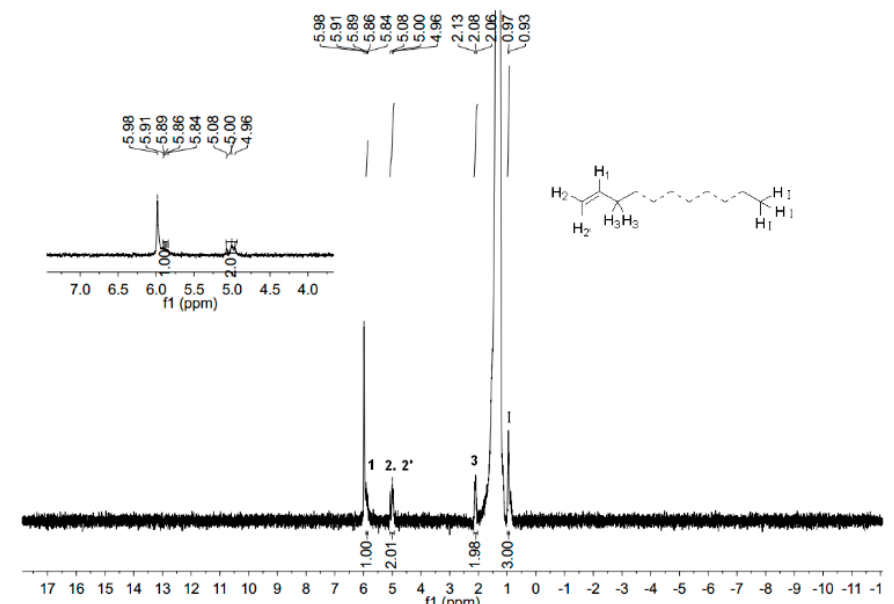
Figure 5. 1 H ‐ NMR spectrum of the polyethylene obtained using Co2 /MAO at 50 °C (run 9, Table 2); recorded in 1,1,2,2 ‐ tetrachloroethane ‐ d 2 at 120 °C.